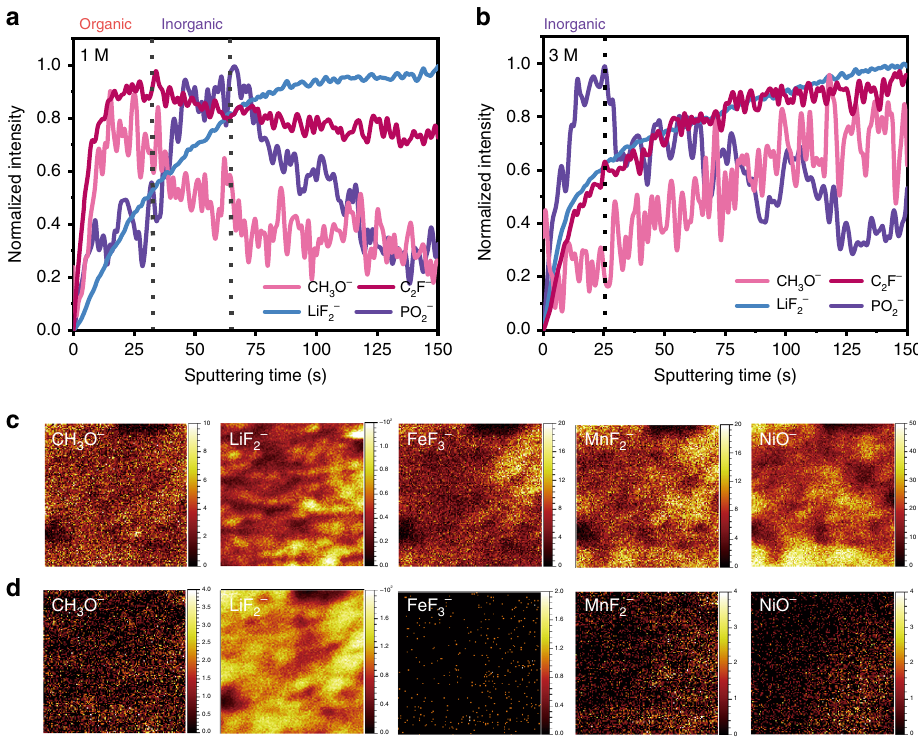
Fig. 6 TOF-SIMS spectra of interphases on the surface of cycled electrodes. a , b Normalized (to maximum) depth pro fi ling of several typical second ion fragments on the cycled electrode outside surface; c , d TOF-SIMS chemical maps of several typical second ion fragments with 150 s of sputtering on electrodes cycled in 1 and 3 M electrolyte,